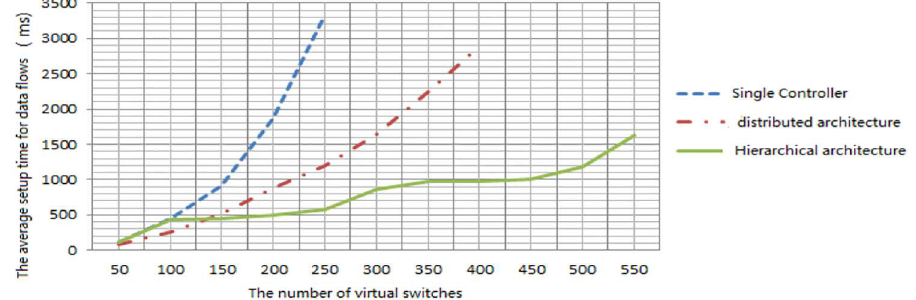
Fig 8. The averagetime of establishing data flows. The single centralized controllerand distributed controller employ the native Ryu controllerand ONOS controller respectively. There are no more than ten virtual switches in each domain and every five controllers are supervisedby an upper